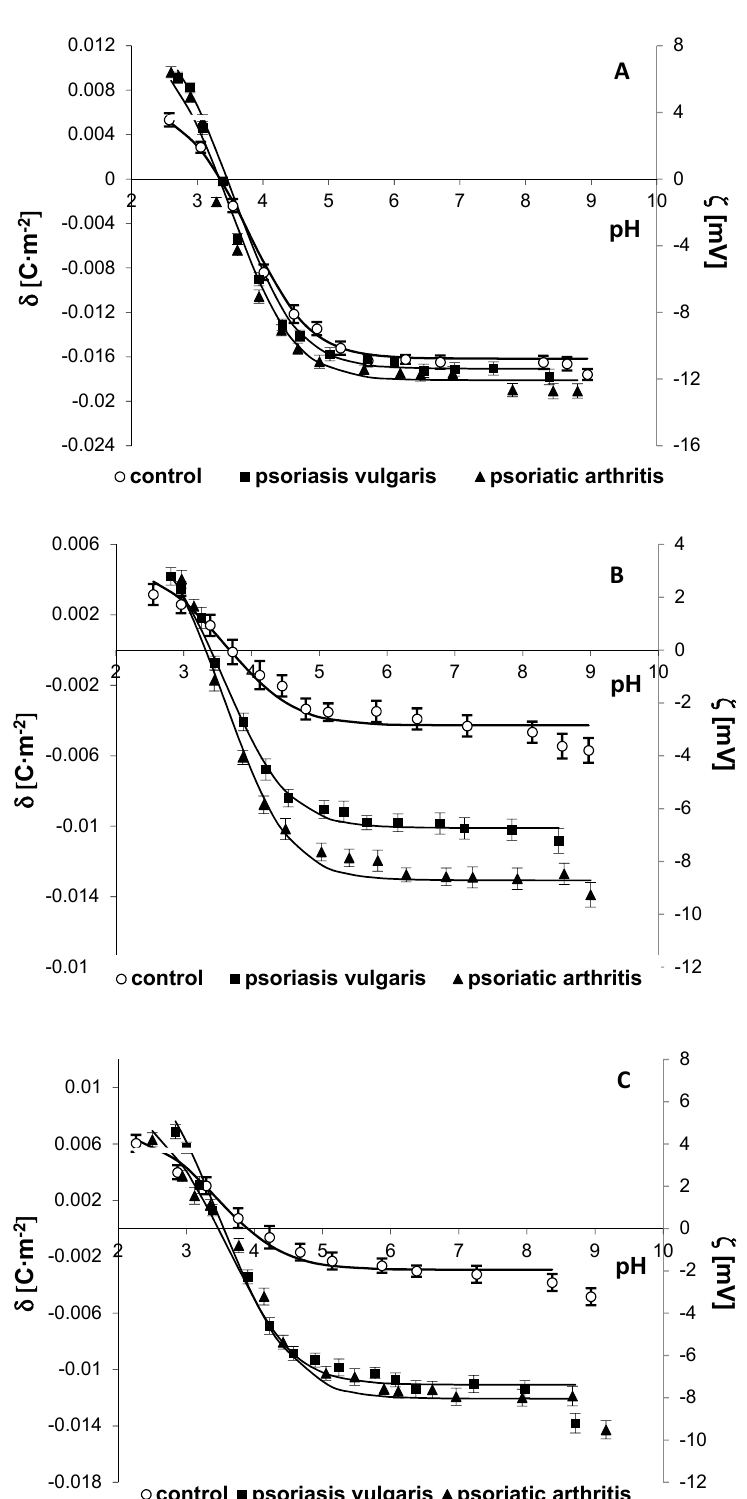
Figure 4. The surface charge density (left axis) and corresponding zeta potential (right axis) of erythrocyte ( A ), lymphocyte ( B ) and granulocyte ( C ) cell membranes of patients with psoriasis vulgaris ( n = 16) and psoriatic arthritis ( n = 8) as well as healthy subjects ( n = 8). Data points represent the mean ± SD.